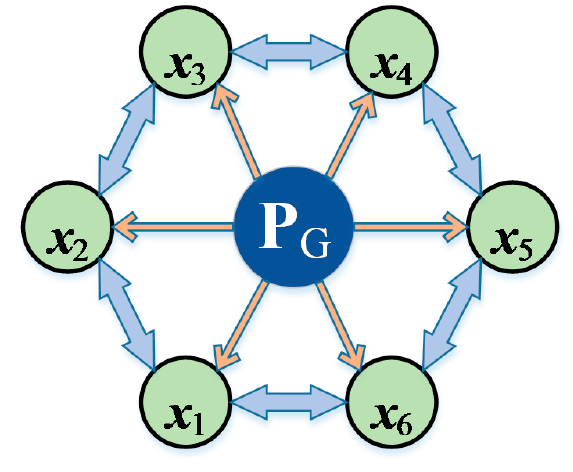
Figure 2. Schematic representation of the ring topology and the solution set P G .